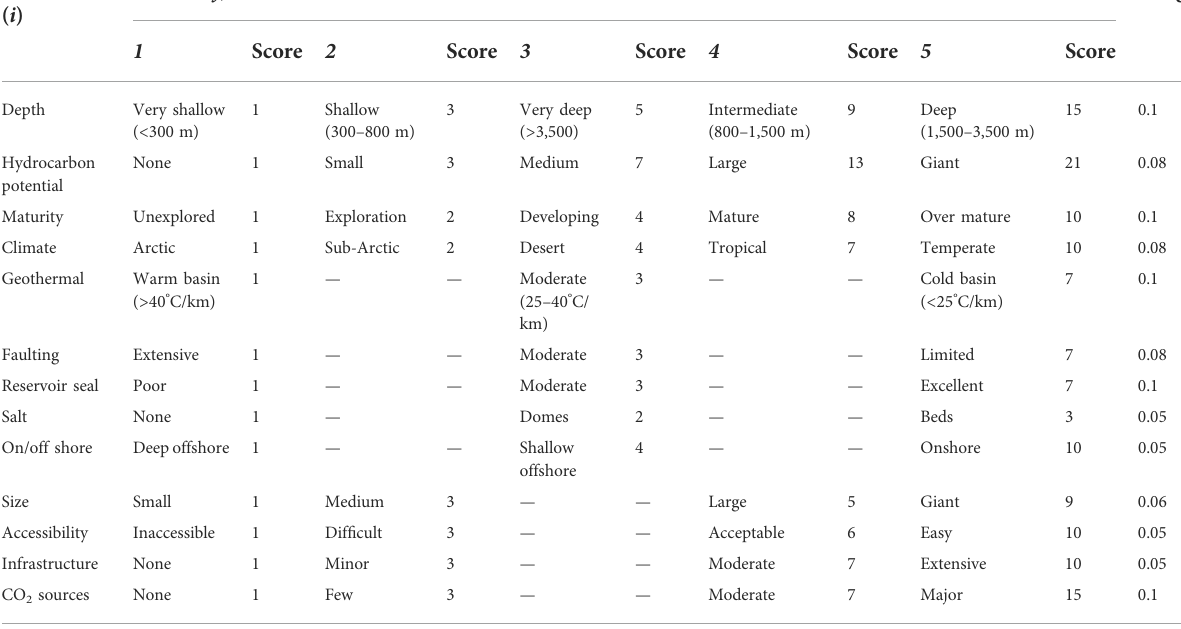
TABLE 2 Evaluation criteria for preliminary assessment of geological CO 2 storage in the Khorat Plateau (adapted from Bachu, 2003). Criterion ( i )